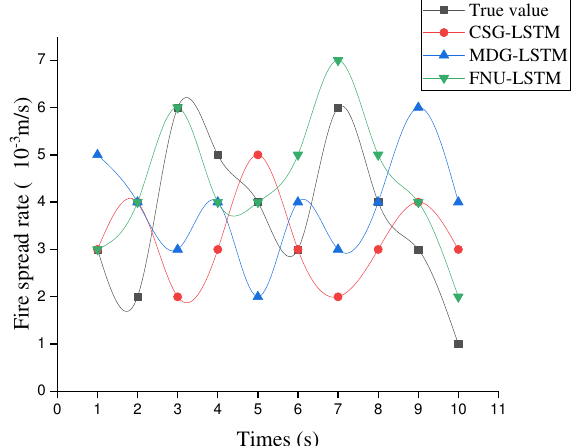
Figure 9. The true forest fire spread value and predicted value from 3 kinds of progressive